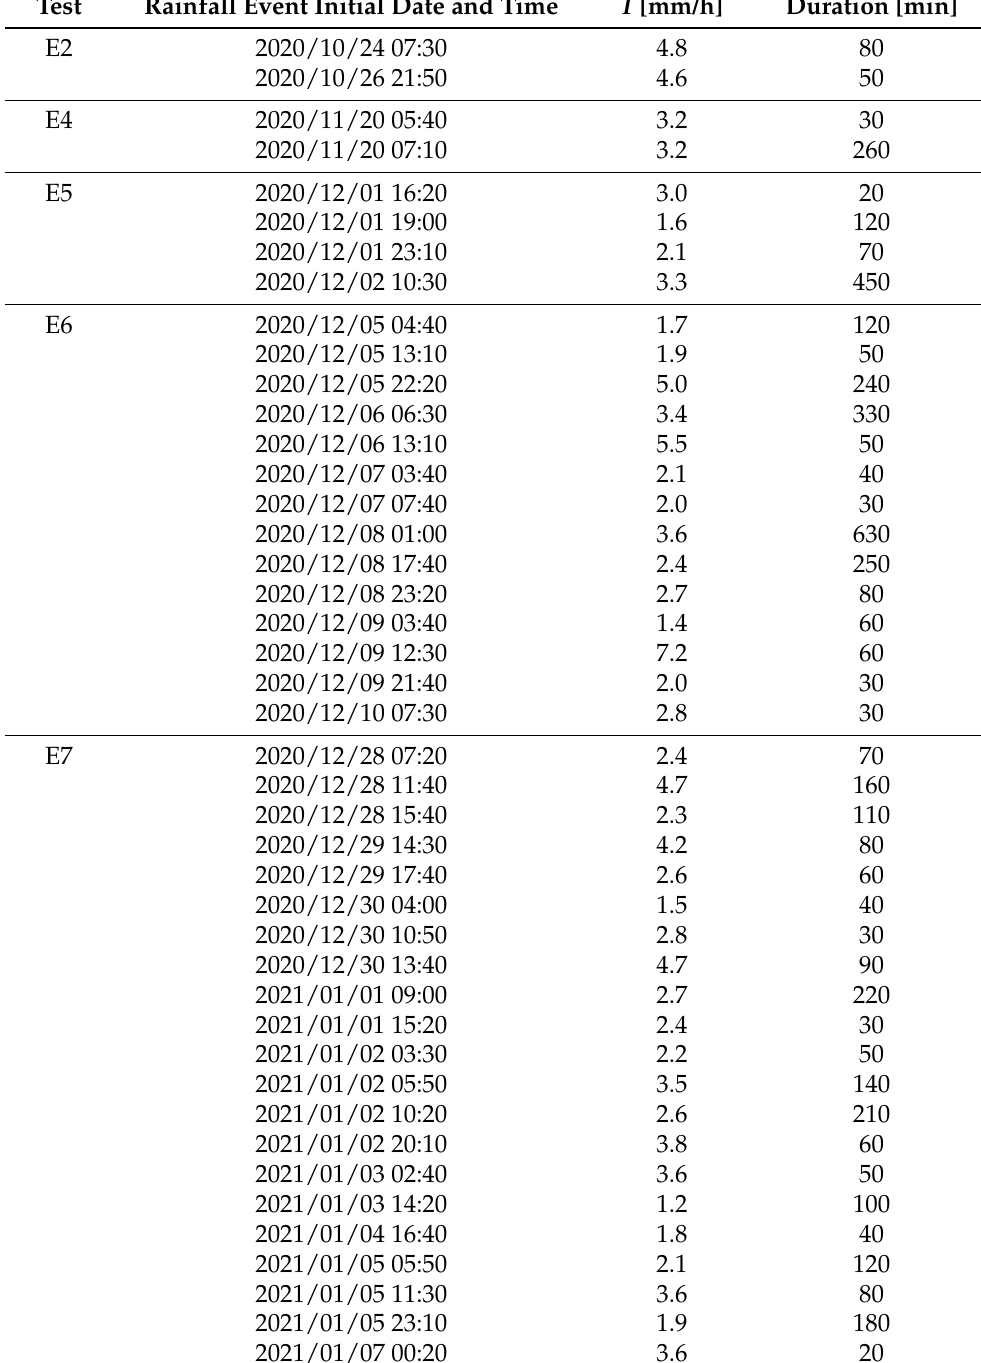
Table 3. Rainfall characteristics ( I , average intensity, and duration) for experimental tests executed during the precipitation